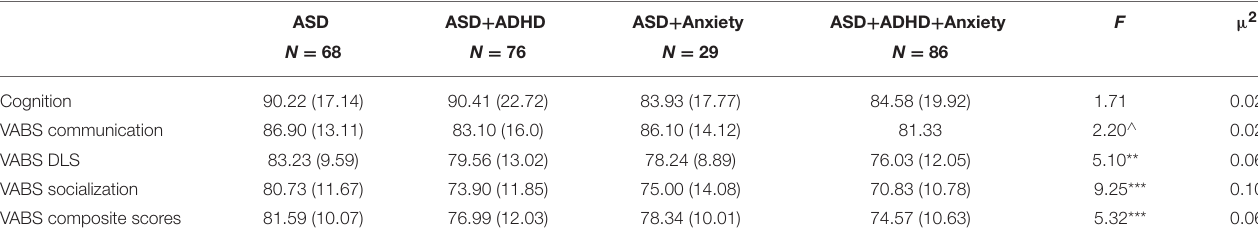
TABLE 3 | Mean scores and standard deviation of IQ and VABS domains in the ASD alone, ASD + ADHD, ASD + anxiety, and ASD + ADHD + anxiety